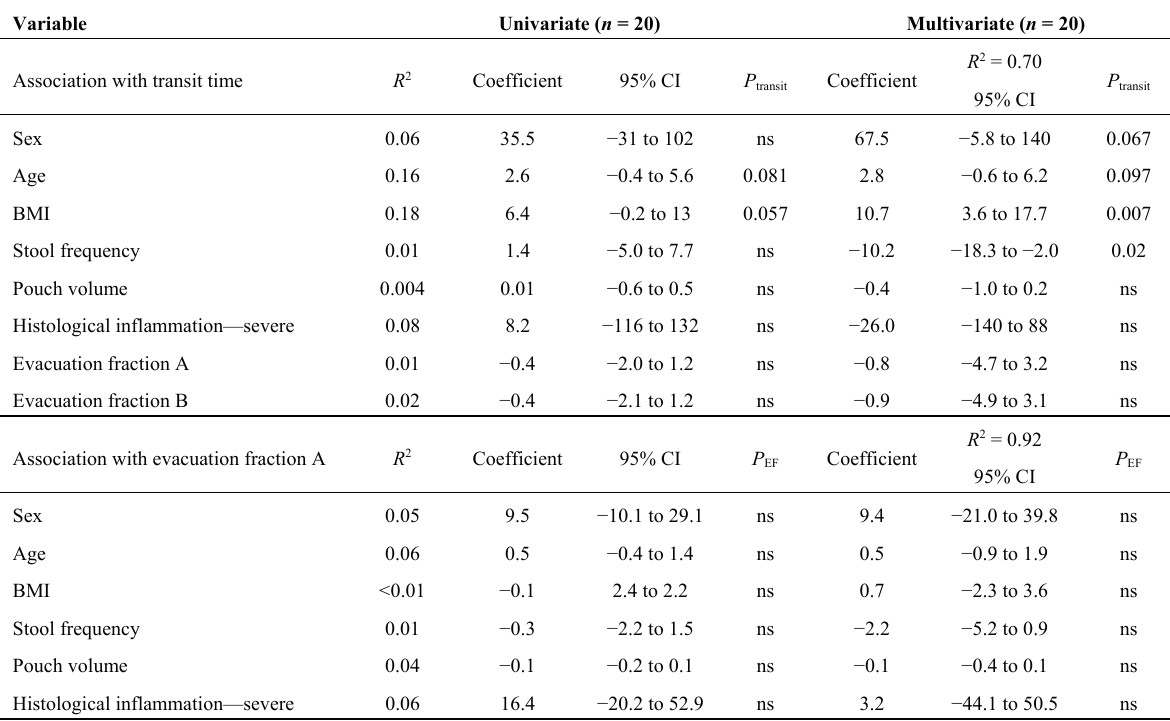
Table 3. Selected results from univariate and multivariate